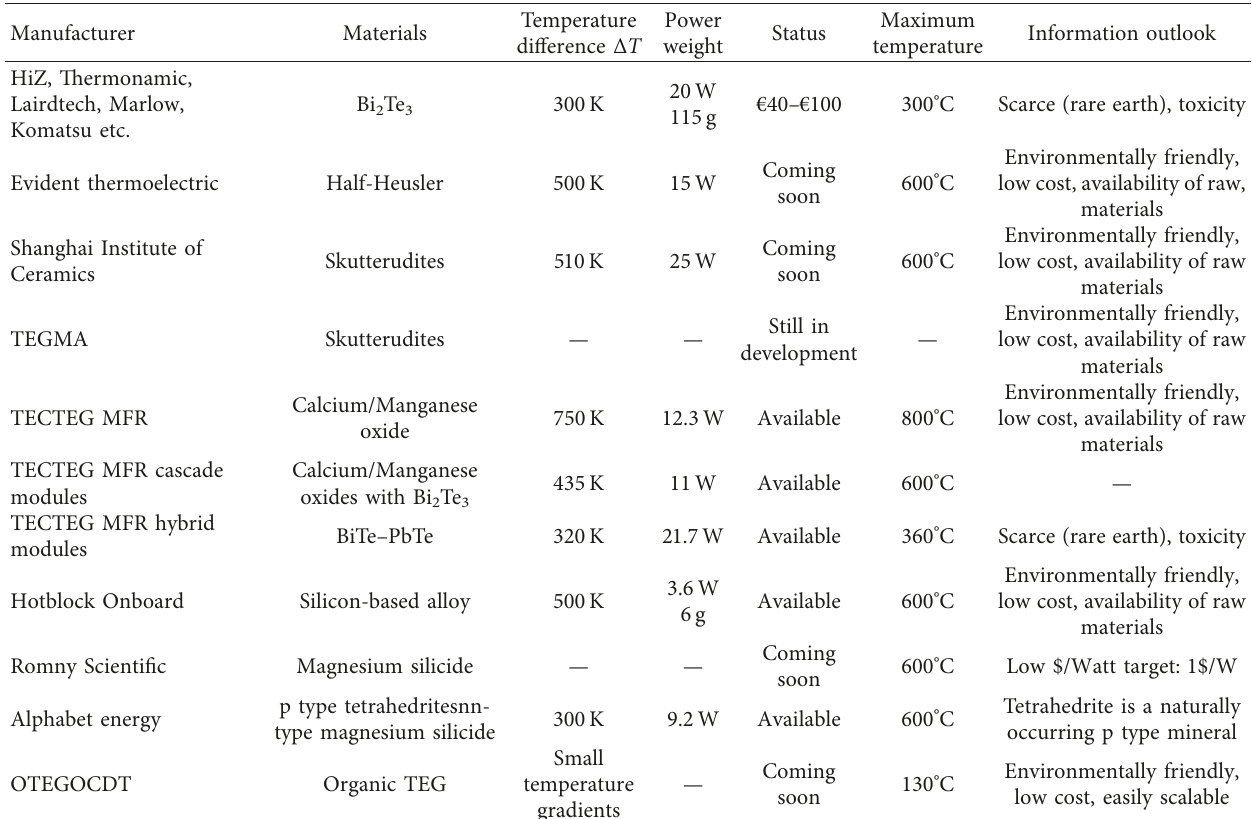
Table 6: List of TE modules and their properties (reproduced from [52] with